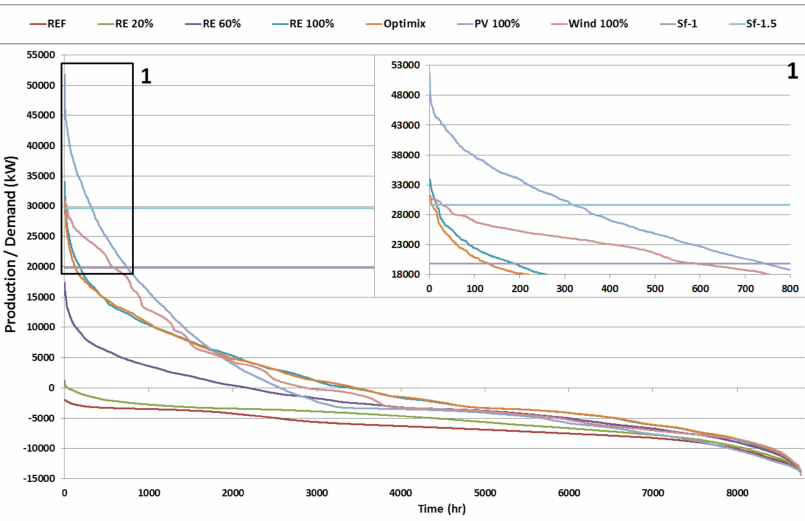
Figure A7. Main LDC results from the renewable integration scenarios.